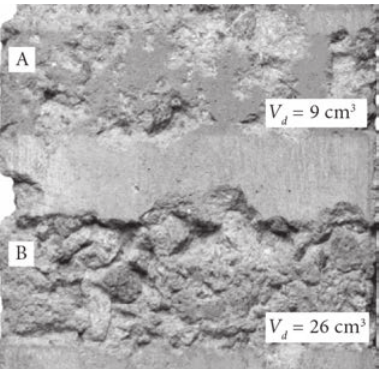
Fig. 6. Example of slots created by rotating continuous jet (A) and rotating pulsating jet (B) in C45/55 concrete ( V d – disintegrated volume, water pressure: 30 MPa, nozzle diameter: 2×1.19 mm, standoff distance: 20 mm (continuous) and 40 mm (pulsating), traversing velocity: 0.2 m.min –1